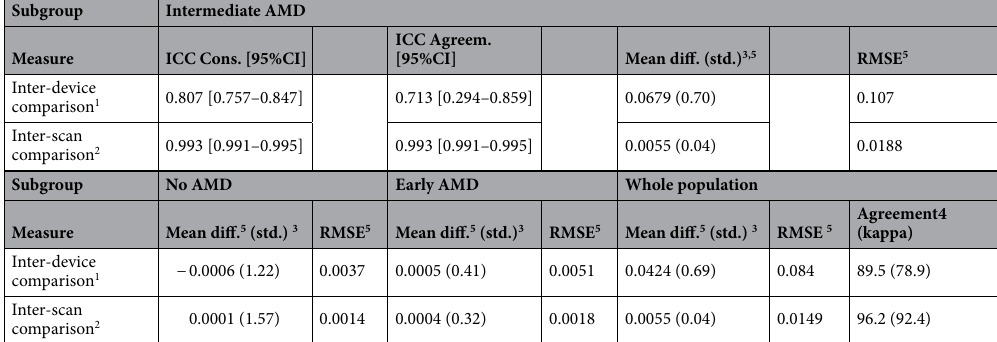
Table 3. Measures of agreement, in the whole population and stratified by AMD stage, across different drusen measurements. ICC intra-class correlation coefficient, Cons. consistency type, Agreem. agreement type, RMSE root mean squared error, Spec. spectralis, AMD age-related macular degeneration, std. standardized, diff. difference. 1 Inter-device comparison refers to the 241 B-scans Spectralis modality and Cirrus. 2 Inter- scan comparison refers to the 241 and 25 B-scans modalities in Spectralis. 3 The standardized mean value corresponds to mean difference divided the mean average value of the twodevices, respectively. 4 Assessed against a binary cut-off indicating high progression risk. 5 Measured in mm 3